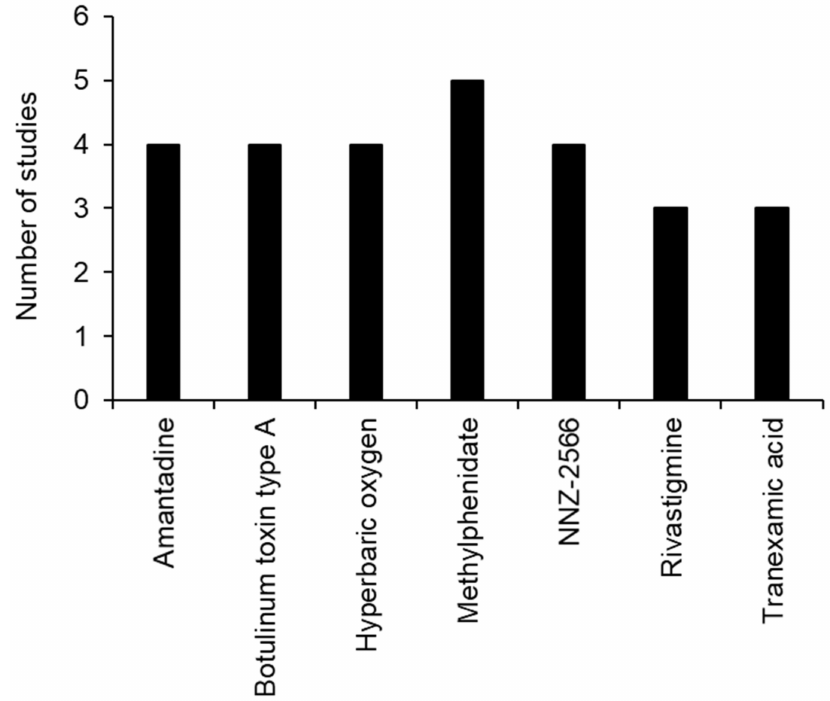
Figure 5. Clinical trials of drugs appearing in three or more registered clinical